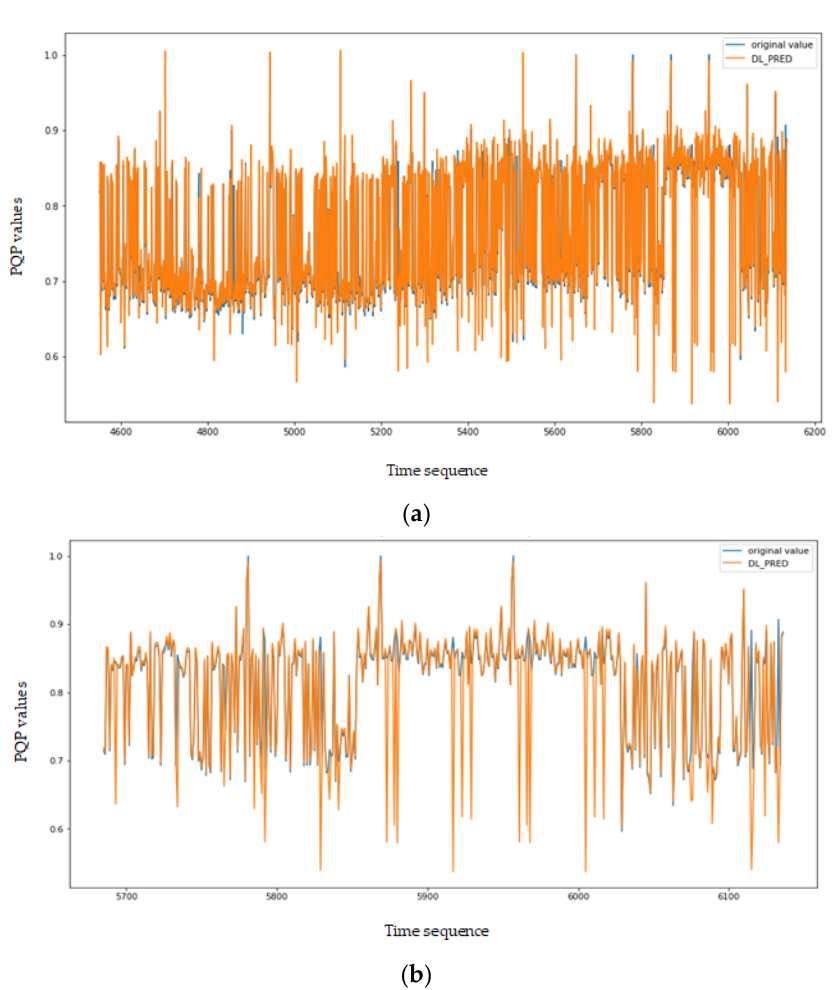
Figure 11. Result of prediction PQP using LSTM; ( a ) result of overall PQP prediction and ( b ) result of PQP prediction for one day.